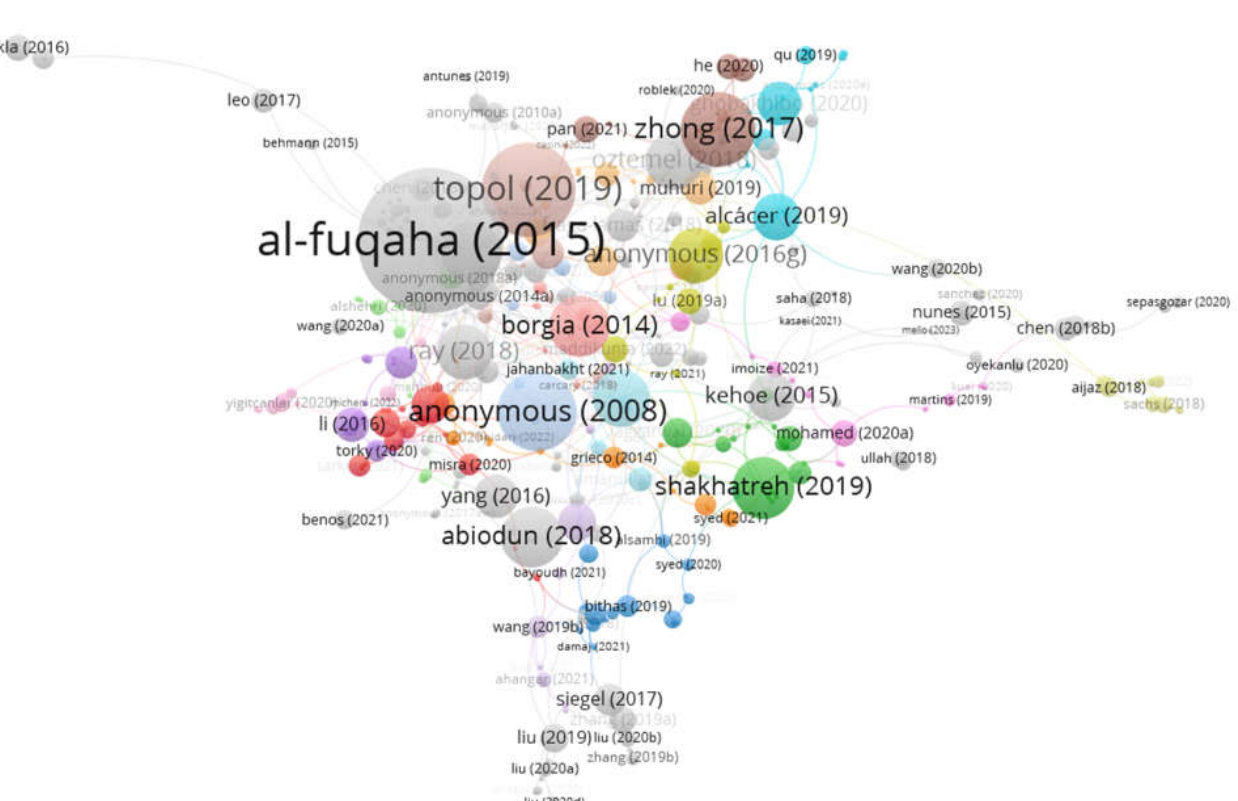
Figure 3. VOSviewer mapping of remote big data management tools, sensing and computing tech- nologies, and visual perception and environment mapping algorithms in the Internet of Robotic Things regarding bibliographic coupling.